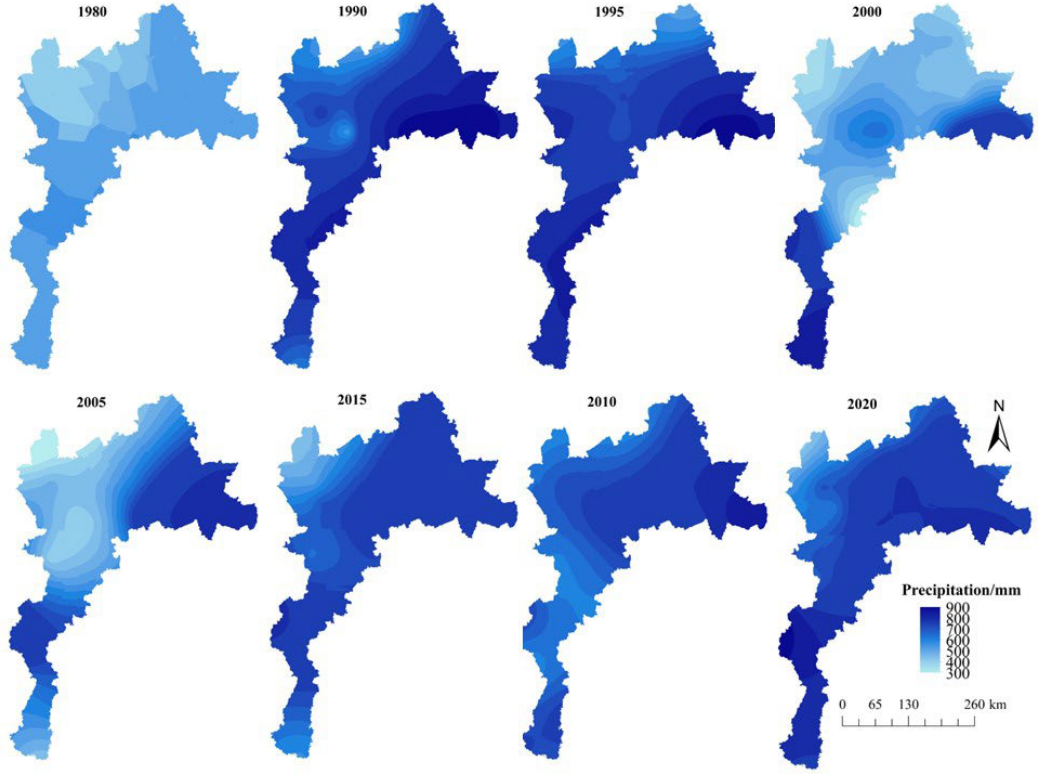
Figure 2. The spatial patterns of annual precipitation in the eight years during 1980–2020.